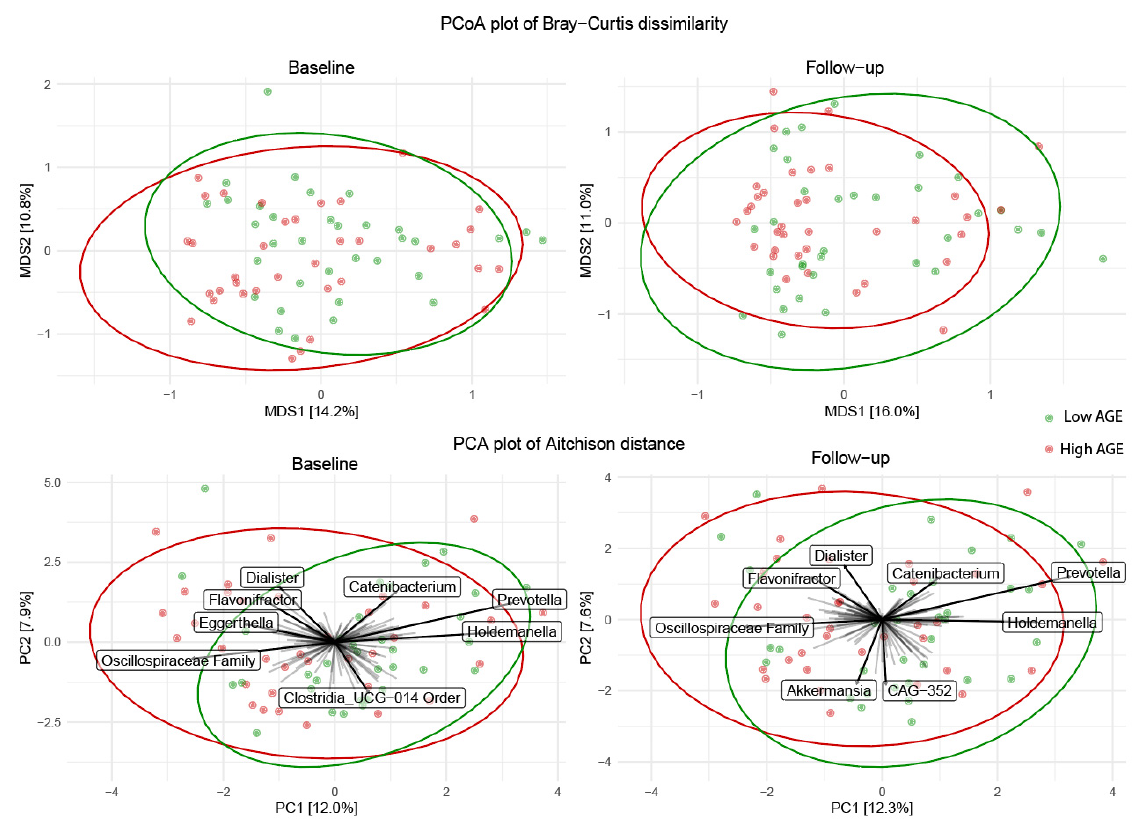
Figure 3. Measures of beta-diversity before ( left column) and after ( right column) a low- or high- AGE diet in abdominally obese individuals. Upper row: principle coordinate analysis of Bray–Curtis dissimilarity. Lower row: Principle component analysis of the Aitchison distance. Sample sizes: low-AGE group n = 34, high-AGE group n = 36.